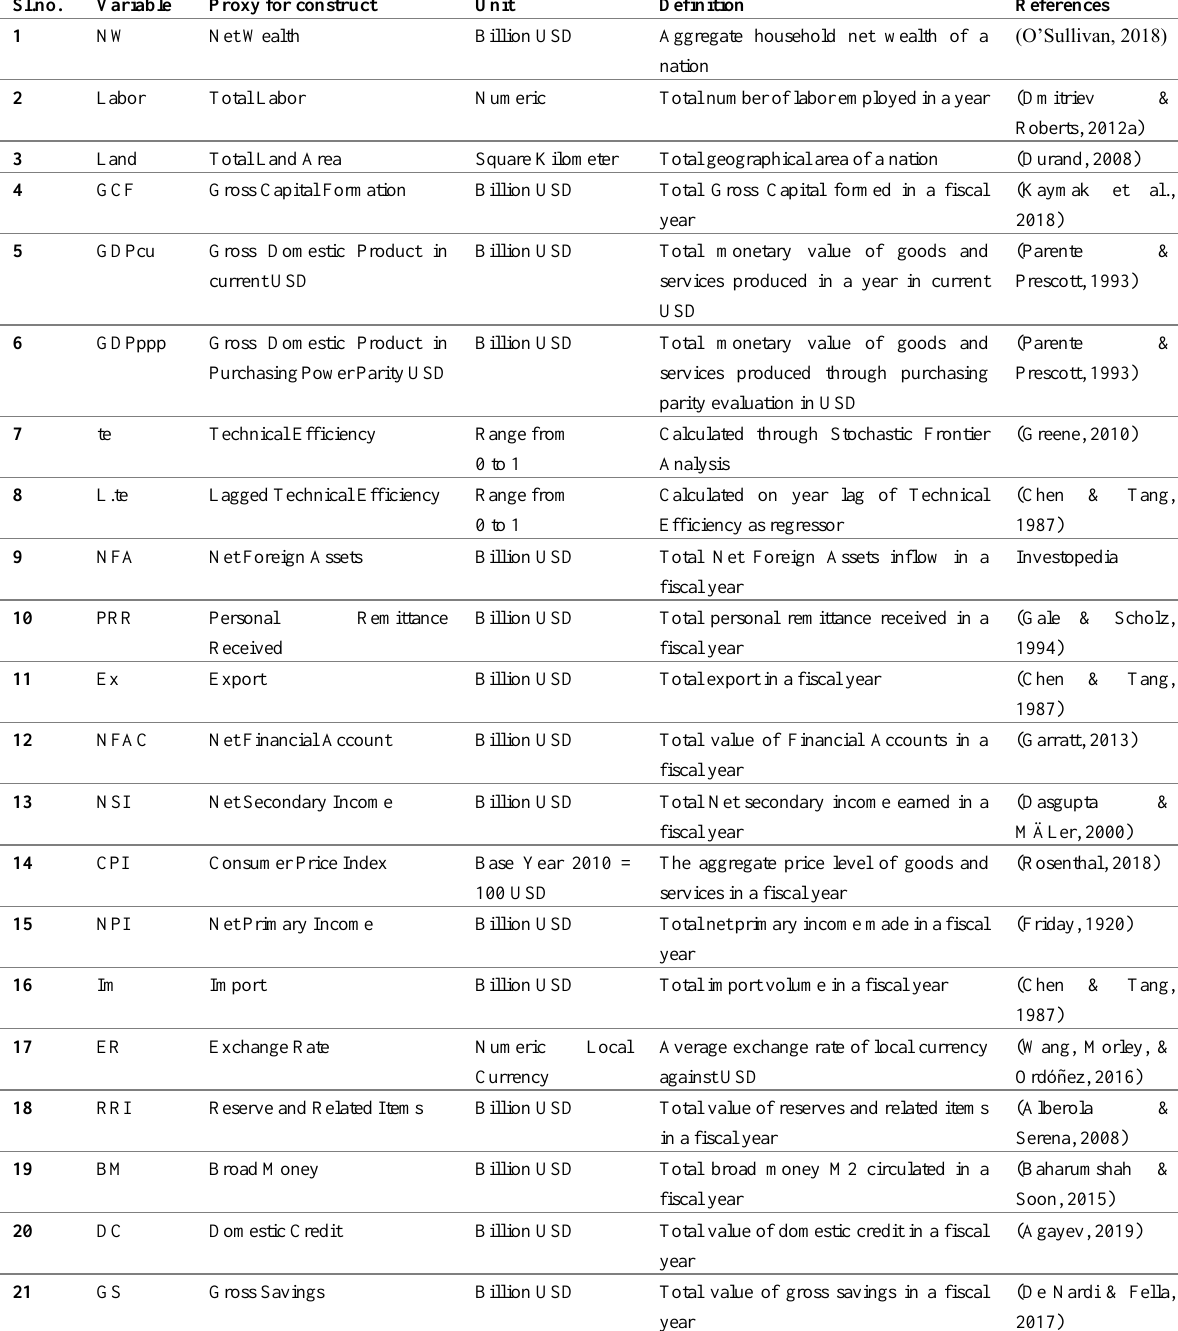
Table 1: The variables supported and discovered from the relevant